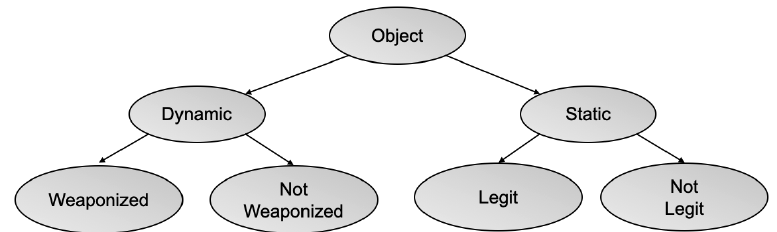
Figure 2. Delivery Objects’